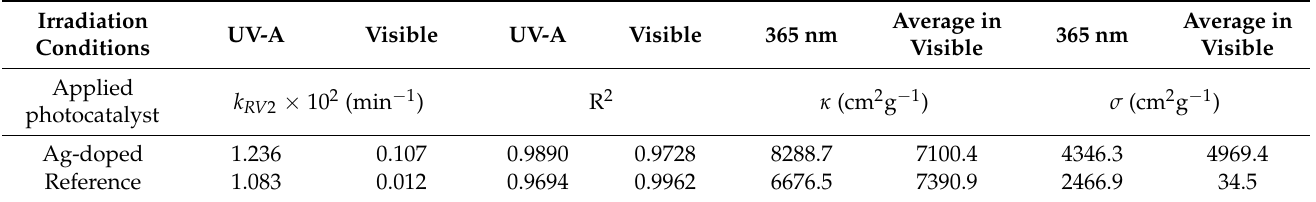
Table 1. Kinetic data for the photocatalytic RV2 dye degradation and calculated absorption and scattering coefficients of photocatalysts under applied irradiation conditions.